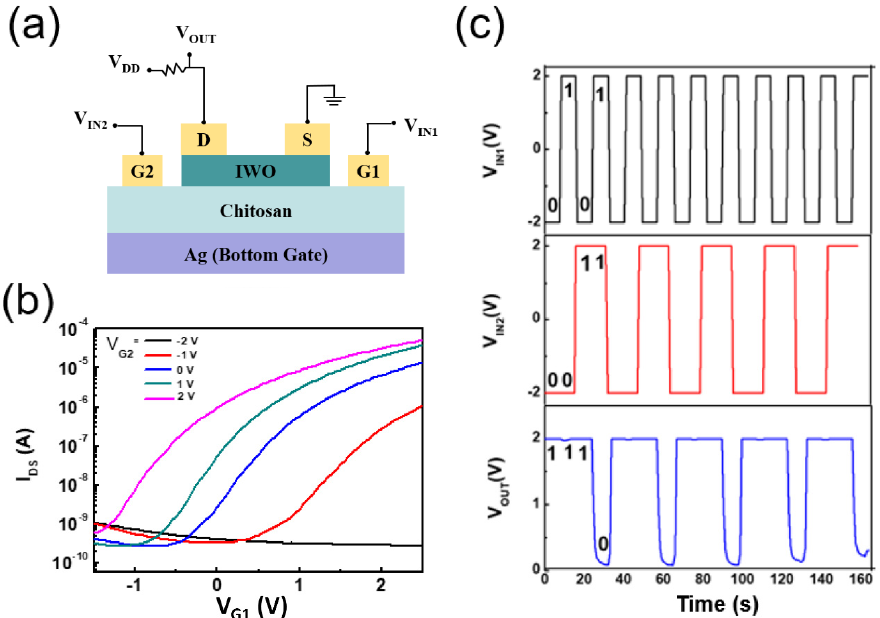
Figure 5. ( a ) Schematic of flexible multi-gate IWO-based TFT in series with a fixed resistor for performing the coordinated modulation and NAND gate; ( b ) Transfer characteristics curve of the TFTs measured with a sweep voltage applied on G1 and modulatory voltages applied on G2; ( c ) NAND logic demonstrated in flexible multi-gate IWO-based TFT.